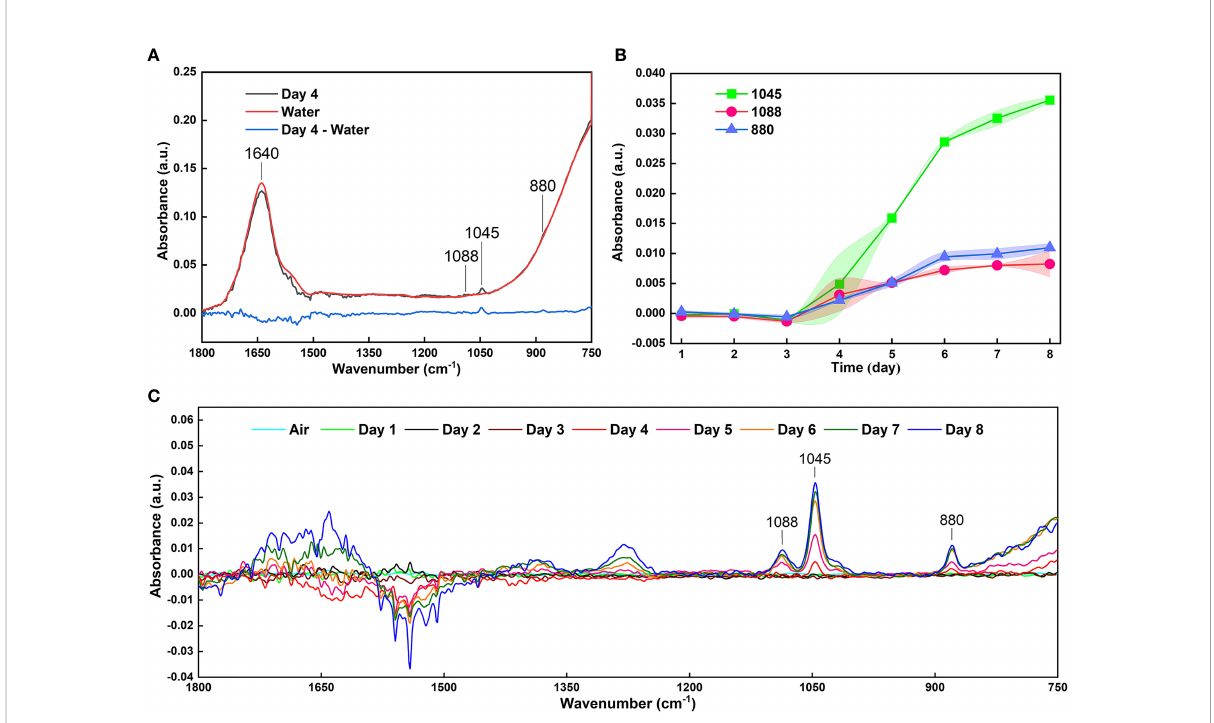
FIGURE 5 (A) Reducing the interference of water absorption by the difference spectra; (B) The curves of the absorbance with an error band at absorption peaks of 1088, 1045 and 881 cm -1 of 40 infrared spectra of grape volatiles after reducing the interference from water absorption; (C) Infrared spectra of grape volatiles after subtracting the interference from water